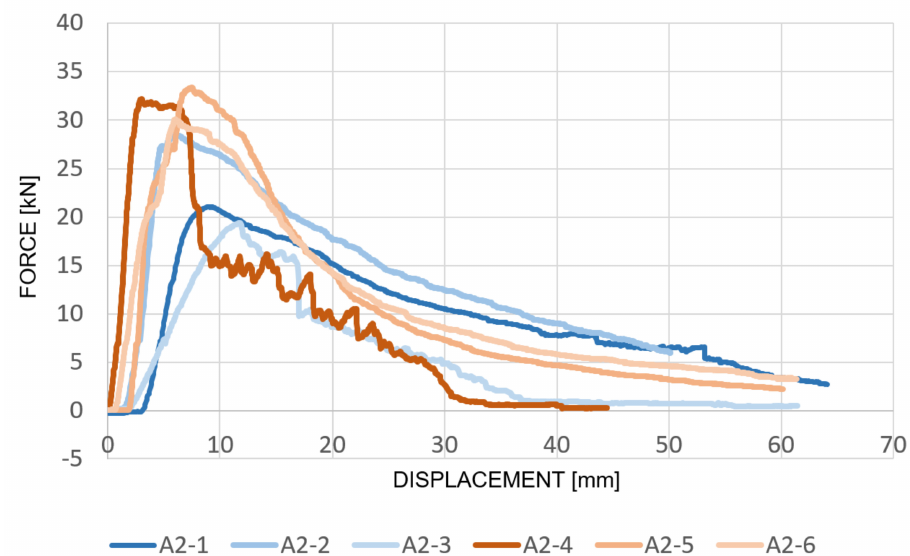
Figure 19. Graphic evaluation of laboratory tests of static point loading of the batch of specimens A2. Specimens A2_1 to A2_3 were tested after blast load, specimens A2_4 to A2_6 were tested before blast